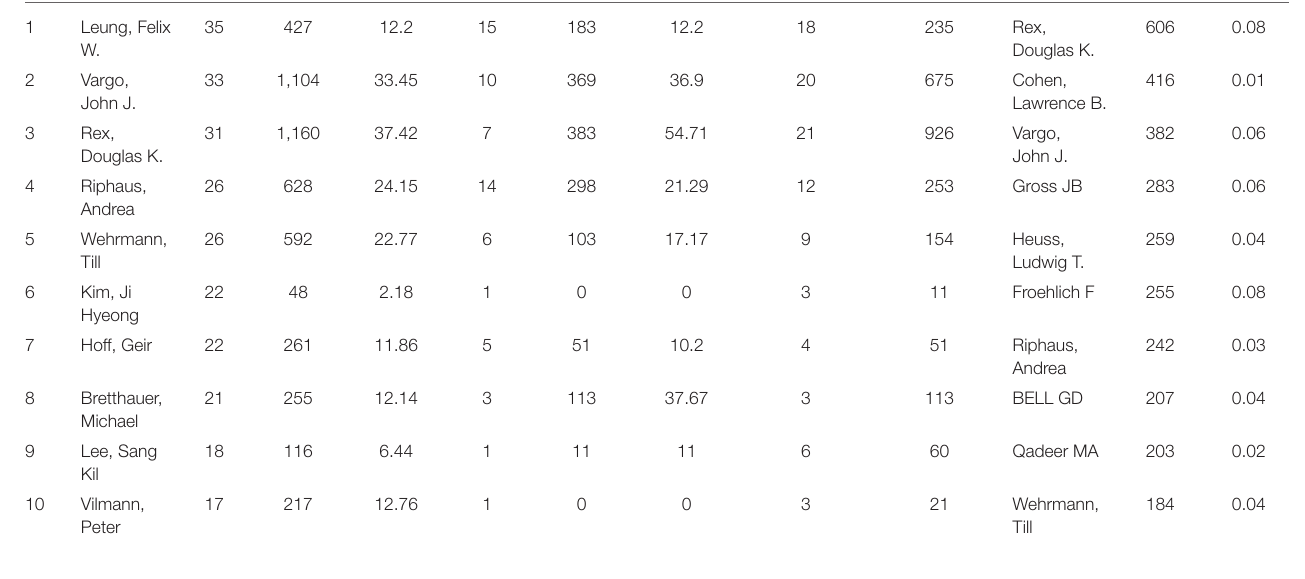
TABLE 3 | The top 10 most productive authors and co-cited authors contributed to publications in Endoscopic Sedation research.